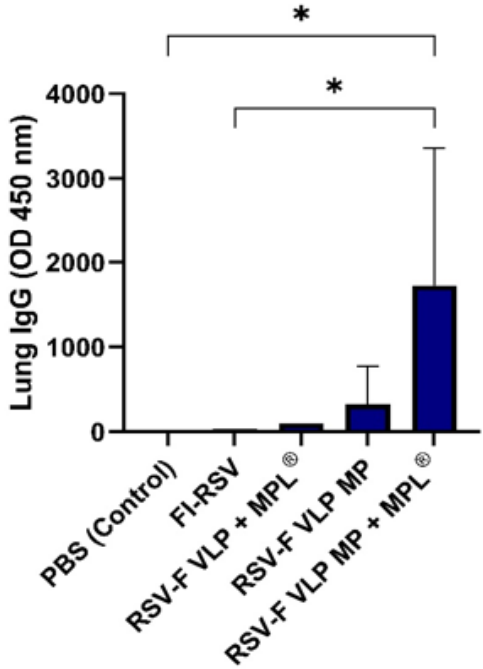
Figure 7. Measurement of lung IgG quantified using ELISA. Lungs were harvested and homogenized at week 14. The lung homogenates were centrifuged at 3000 × g , and the supernatant was used for the assay. Statistical significance was determined using one-way ANOVA in GraphPad Prism. * p < 0.05.